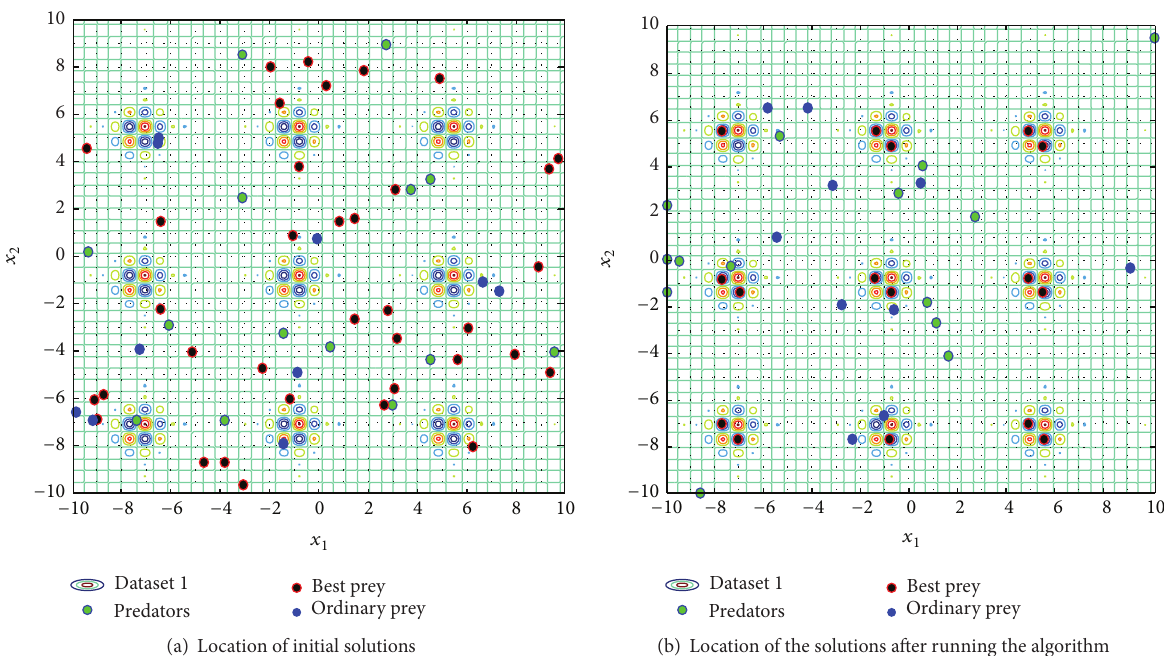
Figure 4: Location of solutions at the beginning and the end of running 𝑛𝑚 -PPA for problem